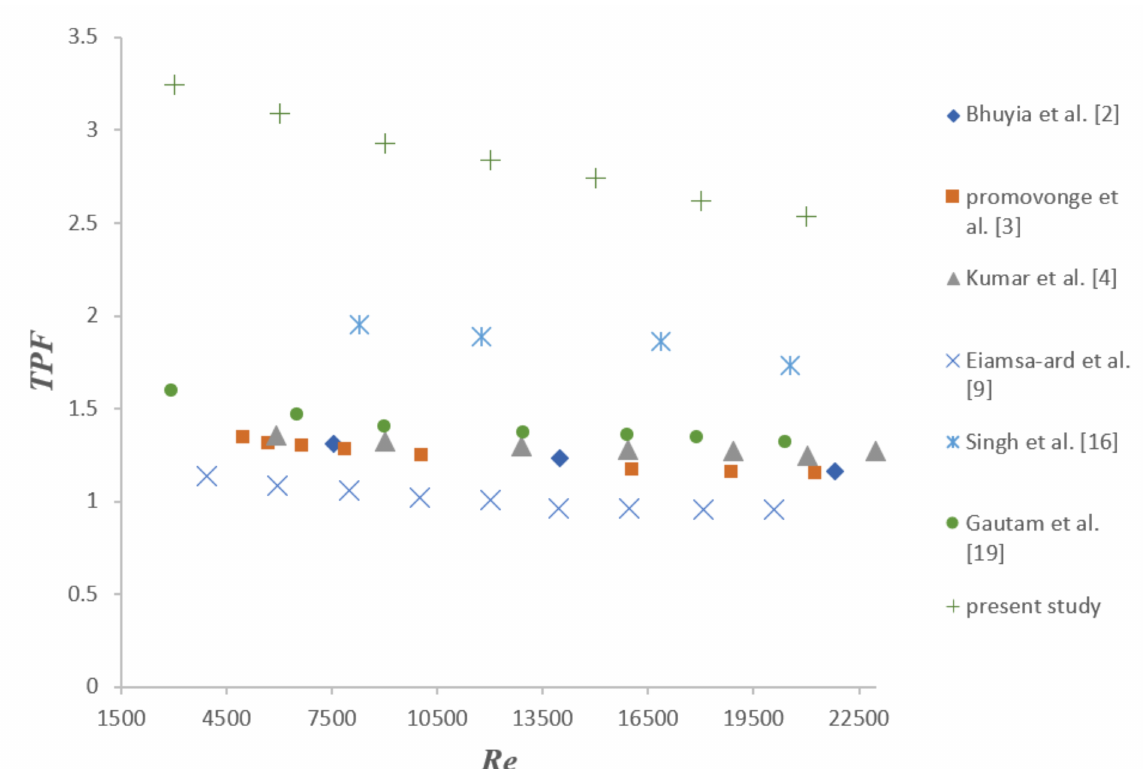
Figure 10. Comparison of triangular perforated Y-shaped insert with previously published